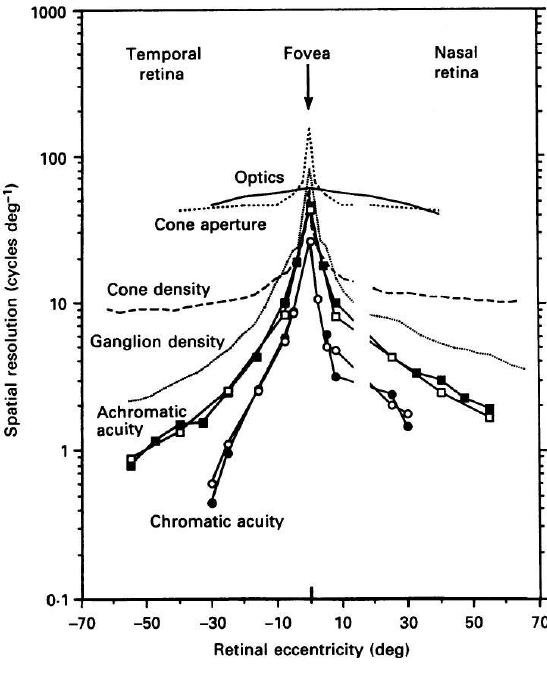
Figure 1. Psychophysical data for the human eye and Optical and Retinal limits of vision. Psychophysical data obtained using drifting gratings at various spatial frequencies, but for a fixed temporal frequency, 8 Hz. Reproduced with permission from